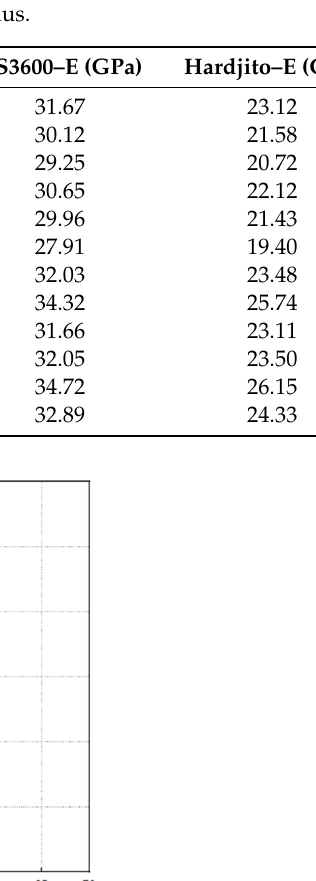
Table 7. Comparison of elastic modulus.